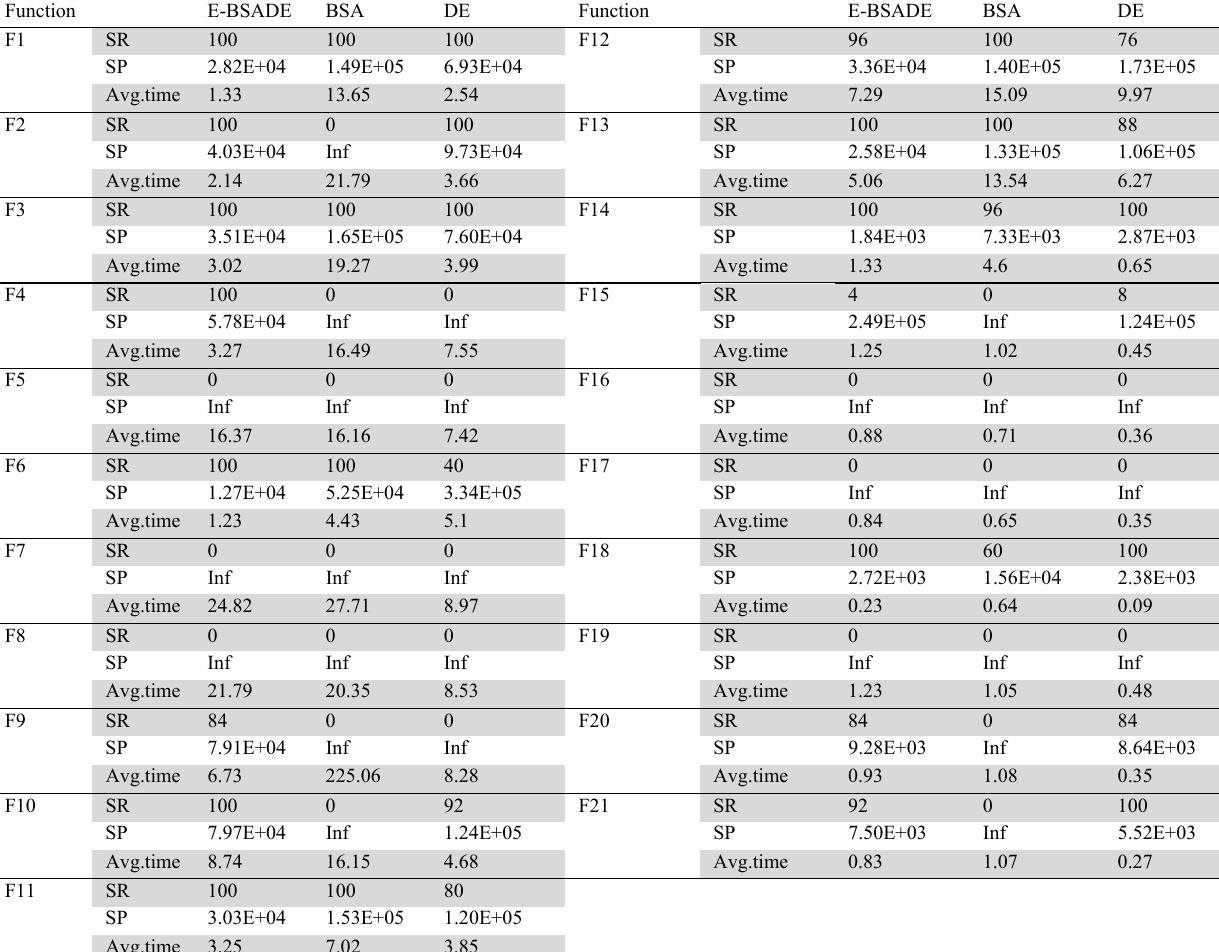
Comparative SR, SP and Average time of 21 benchmark function with BSA and DE algorithms. Function